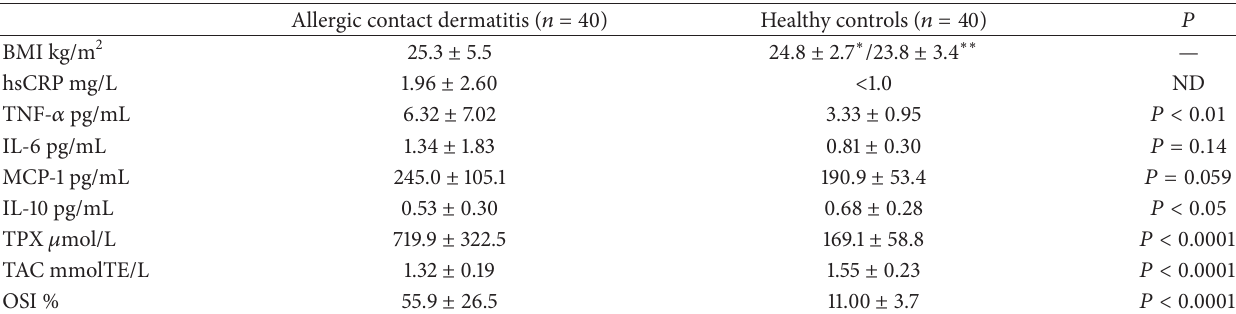
Table 1: The levels of inflammatory markers and oxidative stress characteristics in the patients with acute/subacute allergic contact dermatitis covering approximately 5% of body surface as compared to healthy controls.